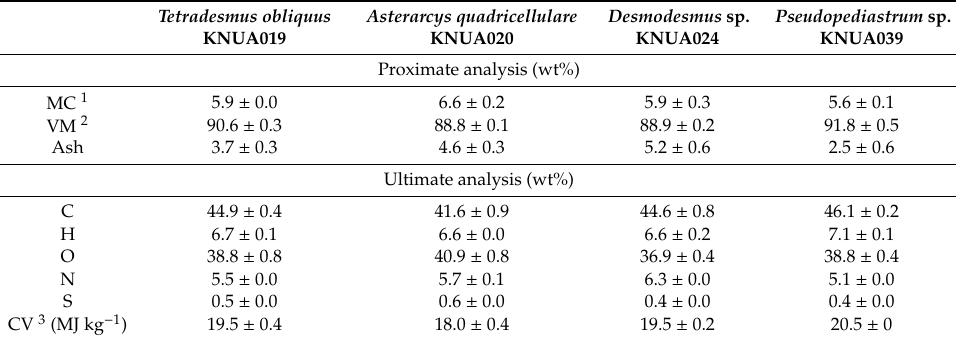
Table 3. Proximate and ultimate analysis of microalgal biomass.